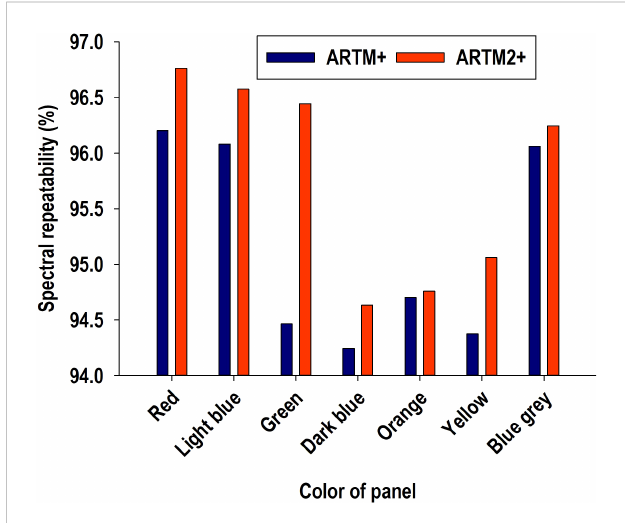
FIGURE 6 Direct comparison of average spectral repeatability of ARTM+ and ARTM2+ calibrations for each of the seven color panels. ARTM+ calibration is based on data from 131 spectral bands from 406-970 nm, while ARTM2+ calibration is based on data from 115 spectral bands from 406-900